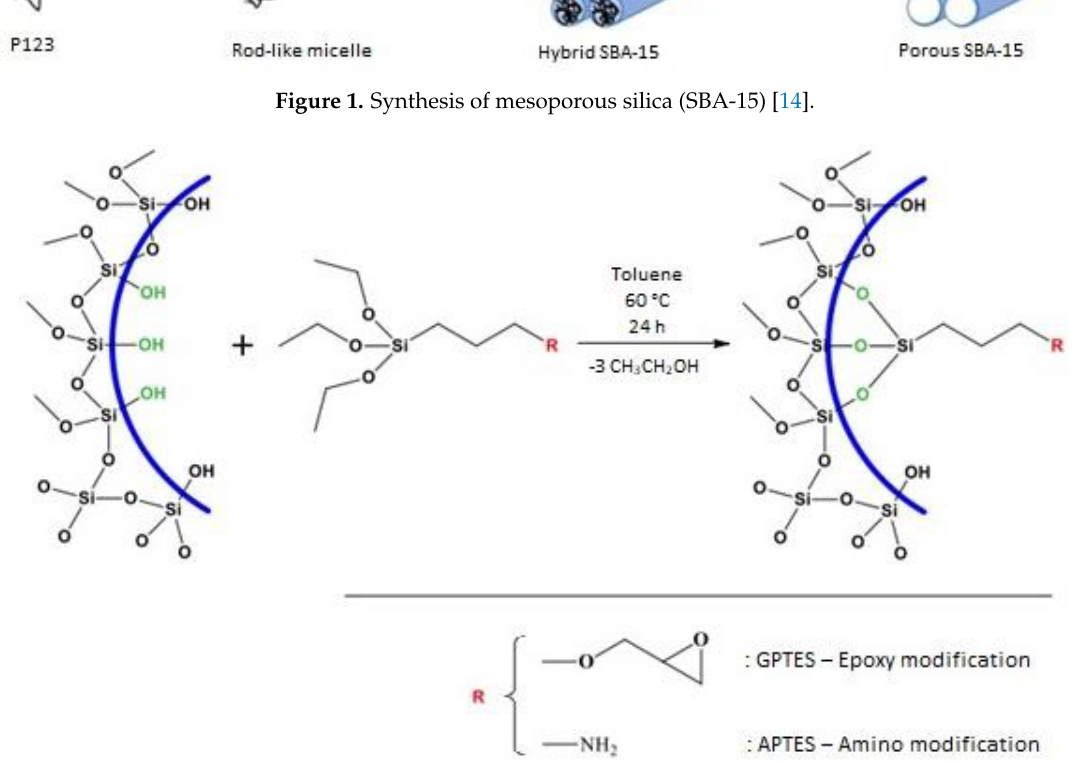
Figure 2. Mesoporous Silica surface modification by alkyl-silanes [14]. Table 1. Synthesis path of SBA-15 and of modified SBA-15 [14].